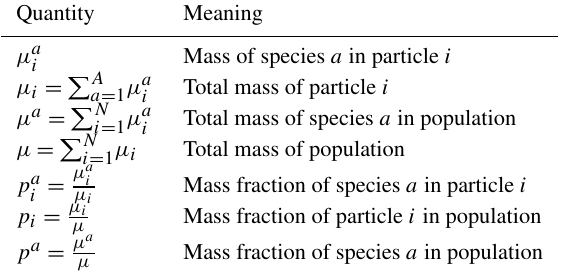
Table 1. Aerosol mass and mass fraction definitions and notation. The number of particles in the population is N , and the number of species is A . This table is taken from Riemer and West